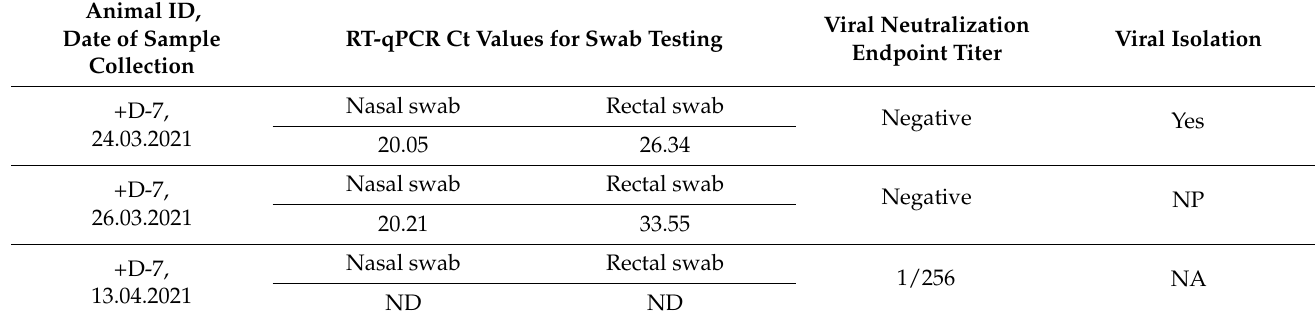
Table 2. Longitudinal SARS-CoV-2 test results for a pet dog from Madrid (Spain) that was confirmed for infection with the B.1.1.7 variant of concern